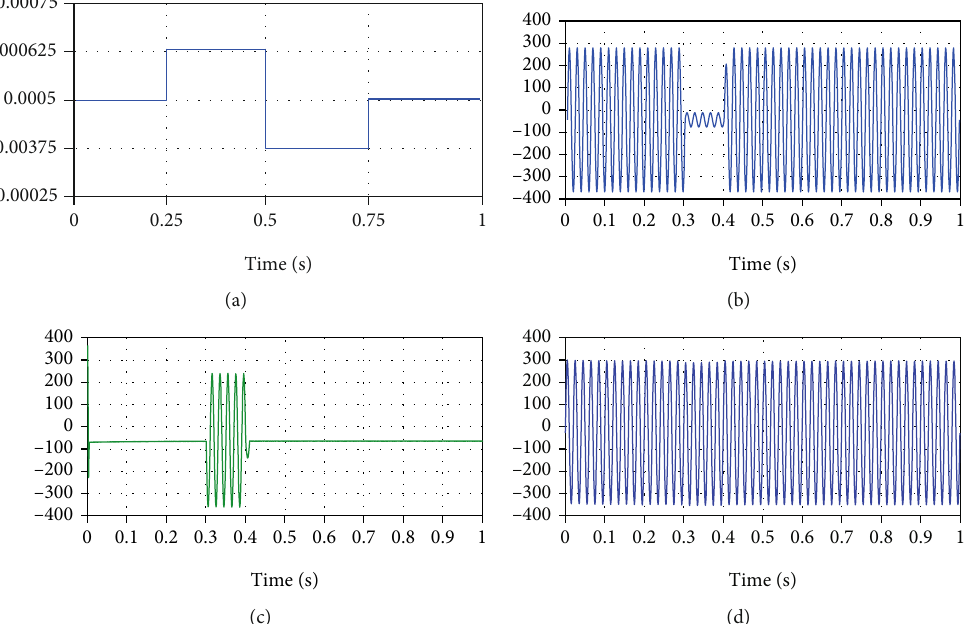
Figure 13: (a) Grid inductance changes. (b) A sag in the grid voltage estimated ̂ x terminals of the sensitive load after